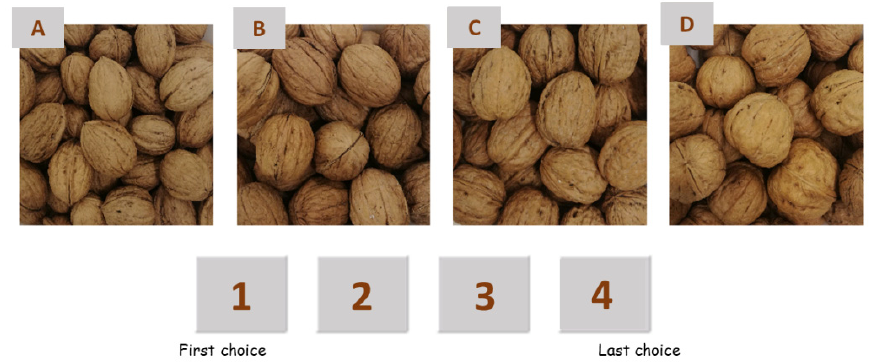
Figure 9. Screen used in the consumer study for evaluating walnut visual aspects. Consumers were asked to sort images of the four walnut varieties from the most preferred to least preferred on the basis of visual appearance. No information about the corresponding name of the cultivar was provided. A = ’Bleggiana’; B = ‘Chandler’; C = ‘Blegette’; D = ‘Lara’ .